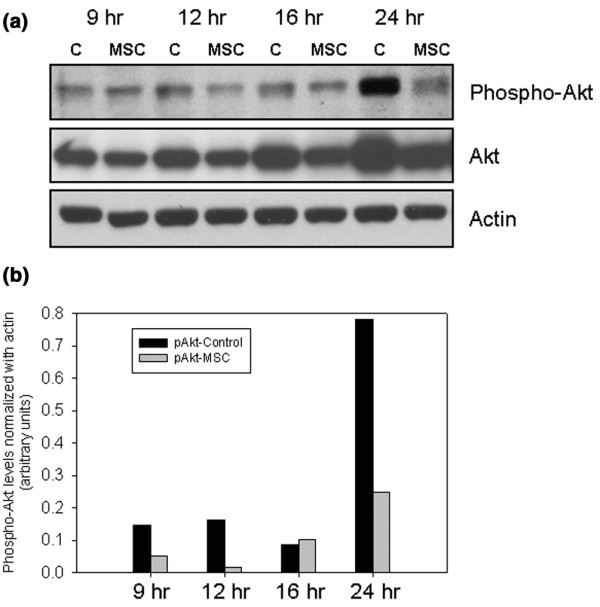
Effect of Se-methylselenocysteine (MSC) on Akt. Synchronized TM6 cells were treated with 50 μM MSC as described in Fig. 1. For each time point three 100 mm dishes were treated with MSC and pooled for protein content. Equal amounts of protein lysates were loaded on each lane (50 μg) for each time point. (a) Immunoblots were probed with anti-Akt, anti-phospho-Akt (Ser473) and anti-actin as described in the Materials and methods section. The phosphorylation of Akt occurring at 24 hours in control cells was inhibited in the MSC-treated cells. (b) The levels of phospho-Akt in control and MSC-treated cells were normalized with respective actin contents and plotted against various time points.